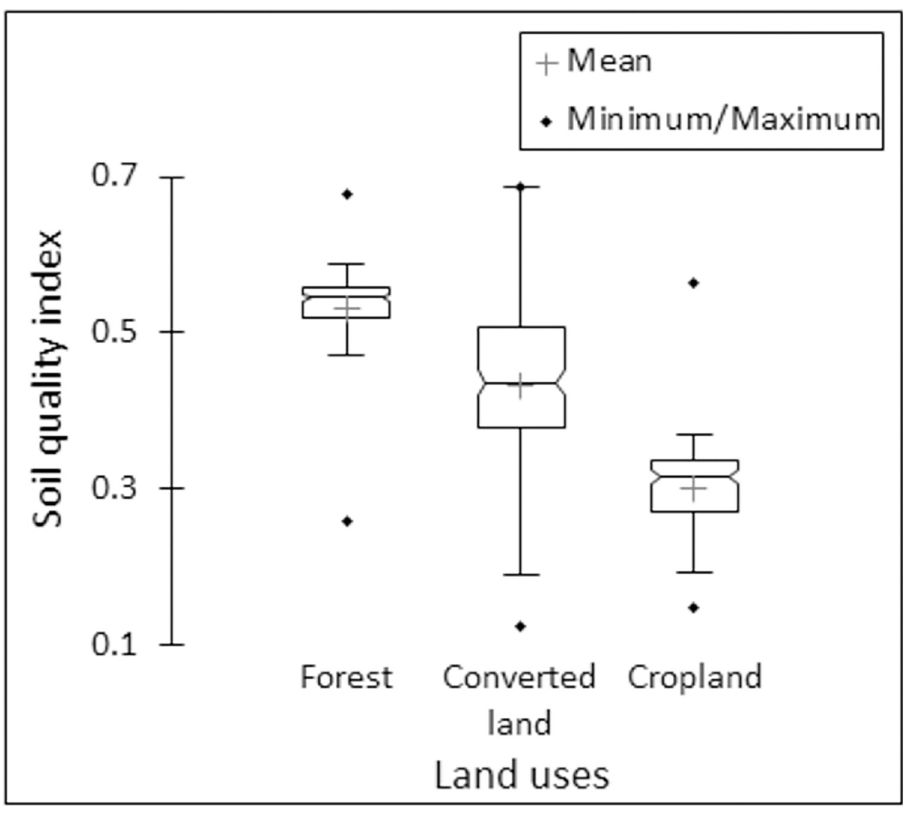
Fig 4. Soil quality index scores under different land use